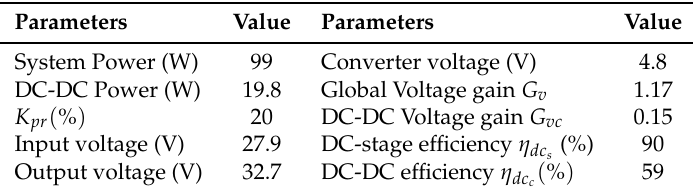
Table 1. Experimental evaluation points.